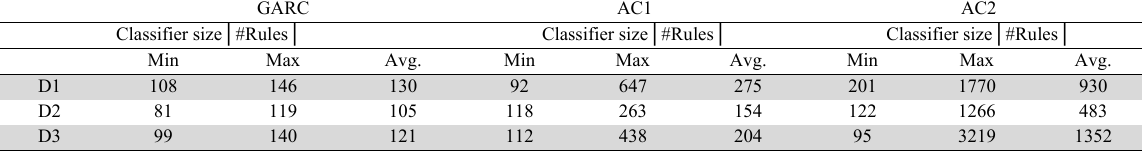
Comparison of GARC and ACs based on the classifier size GARC AC1